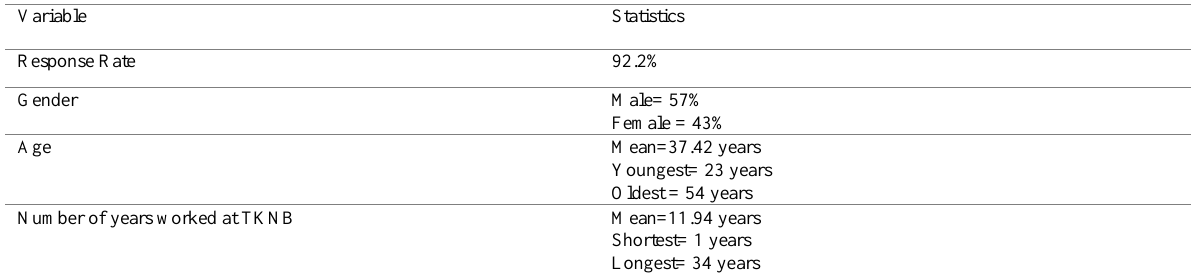
Table 2: Response Rate and Respondents Background